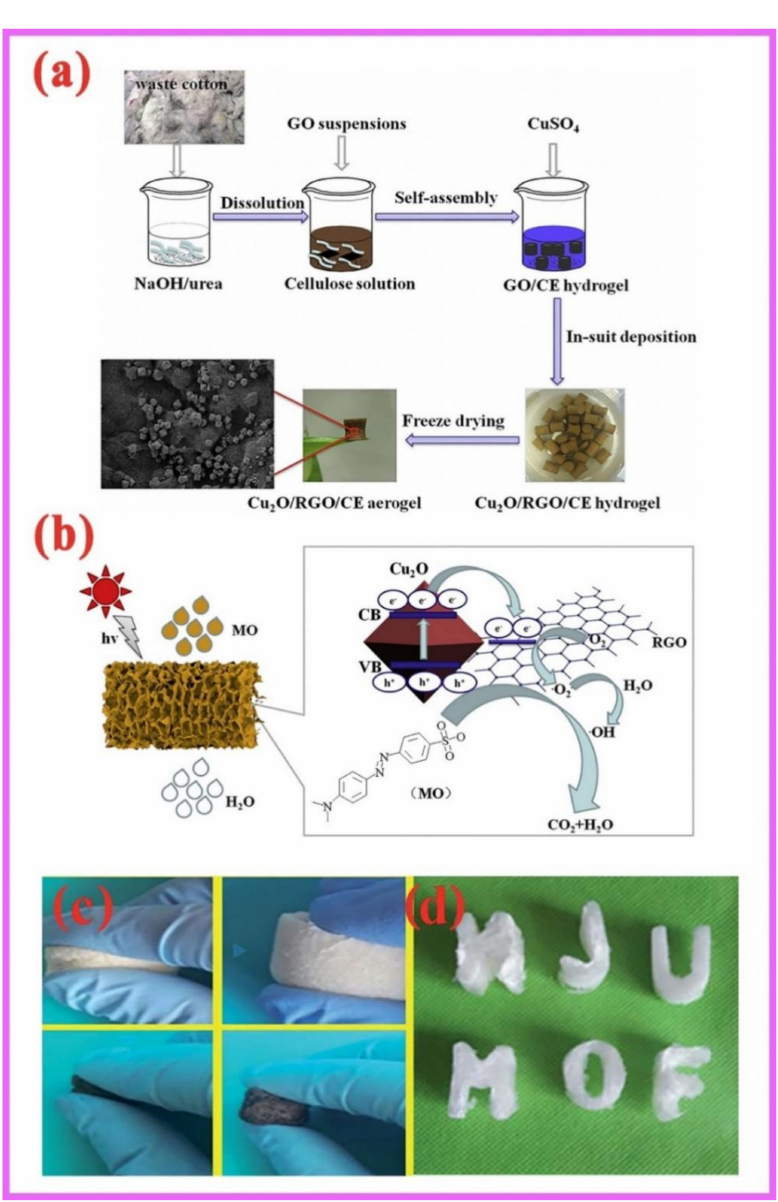
Figure 3. ( a ) Synthesis process of Cu@Cu 2 O/RGO/CE hybrid catalysts; ( b ) Mechanism diagram of Cu@Cu 2 O/RGO/CE photocatalytic degradation of MO; ( c ) Elasticity test map; and ( d ) plasticity of BMFAs